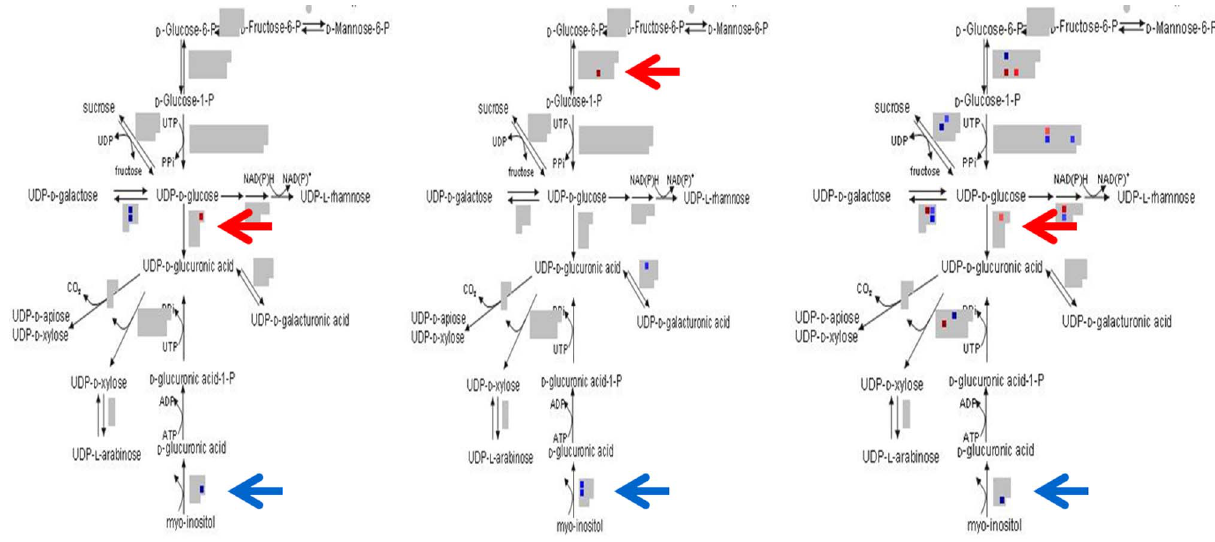
Figure 7. MapMan software illustrates the cell wall precursor pathway and effects of the Li 1 and Li 2 mutations. Enzymes involved in the synthesis of UDP-D-glucaronic acid are altered in both Li 1 and Li 2 mutants. Blue indicates up-regulated probes and red indicates down regulation. The arrows point to steps of the pathway that are discussed in more detail in the text.